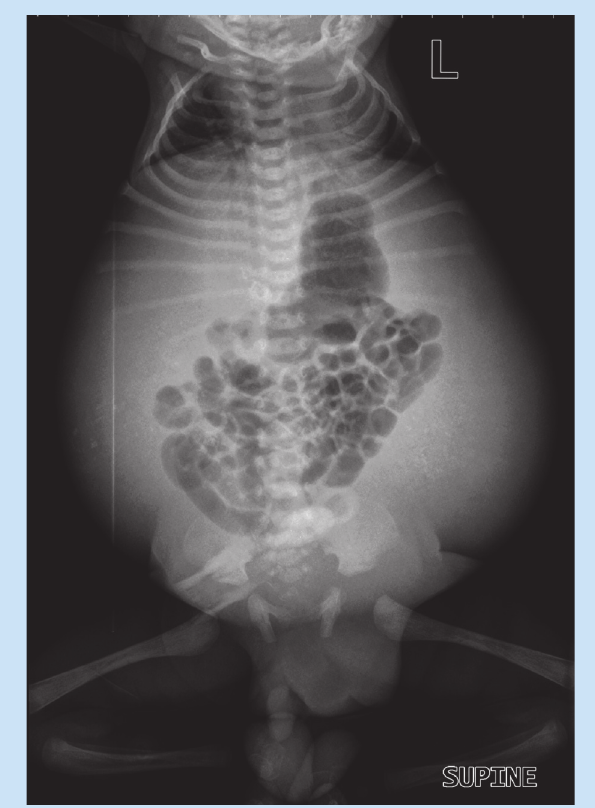
Fig. 1. Supine abdominal X-ray revealing a massively distended abdomen with poor lung capacities. The bulging flanks and central floating bowel loops indicate ascites. Note the intra-abdominal calcifications.